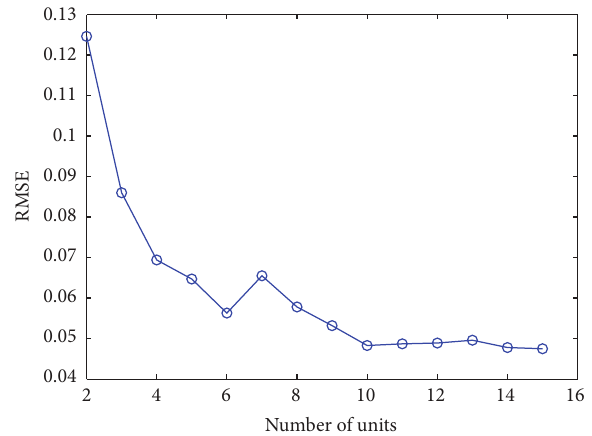
Figure 6: RMSE for various number of units in hidden layer.